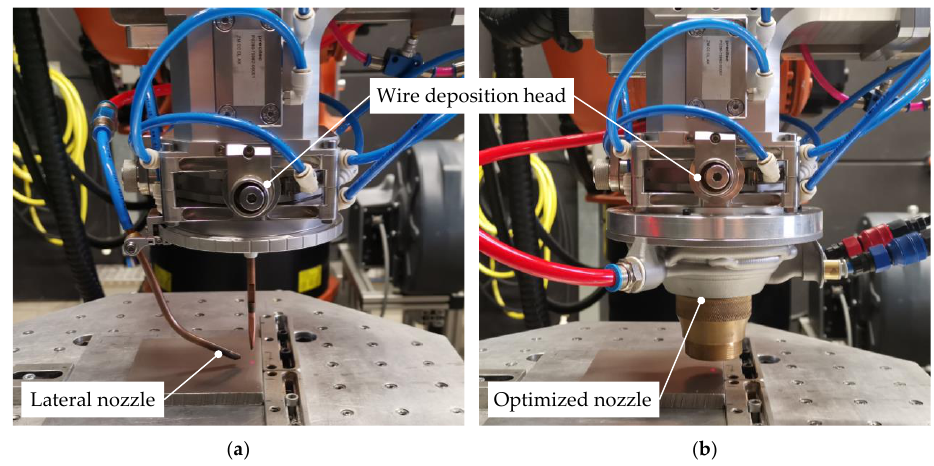
Figure 5. Configurations of the investigated shielding gas concepts: ( a ) lateral shielding gas nozzle; ( b ) optimized coaxial shielding gas nozzle.